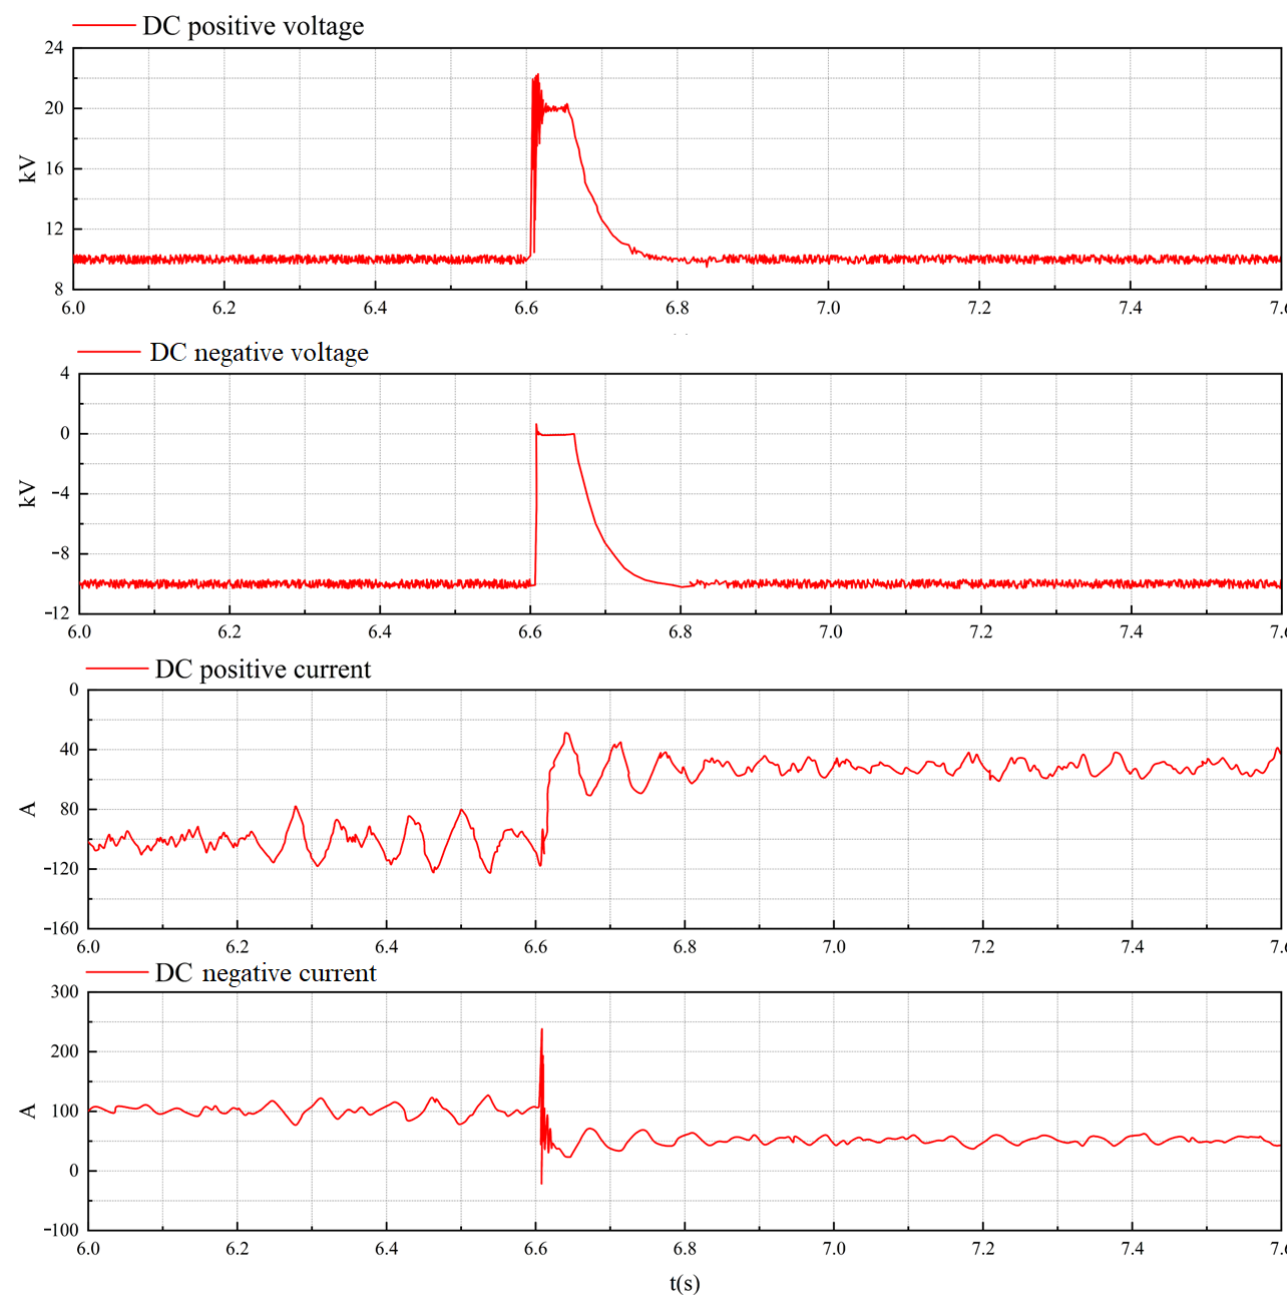
Figure 7. Waveforms of T1.